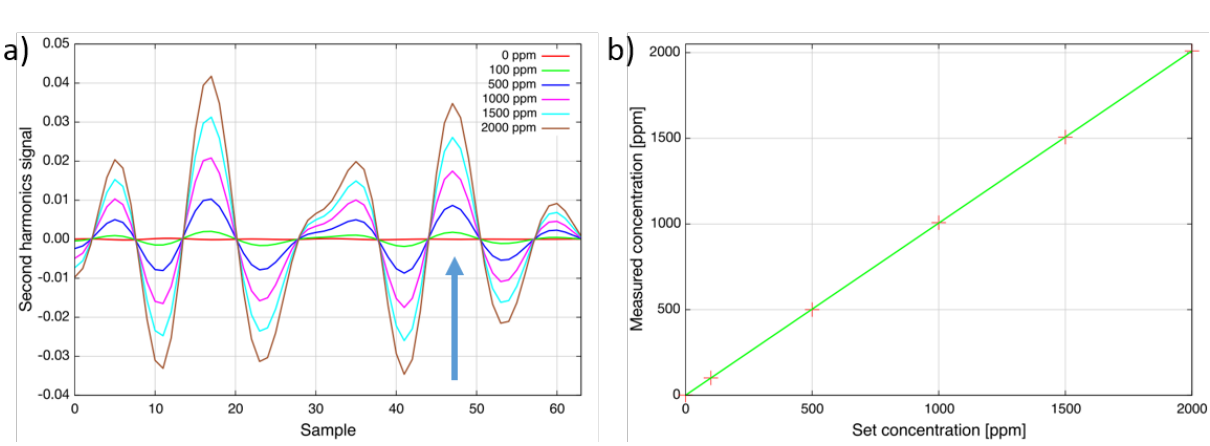
Figure 3. ( a ) Second harmonic spectra of sulfur dioxide for different concentration levels at 160 °C. The target line at Sample 47 is indicated by an arrow. The total wavelength tuning is approximately 1 cm − 1 ; ( b ) Linear response at 160 °C. These figures have previously been used in the presentation of Geiser et al. [13].